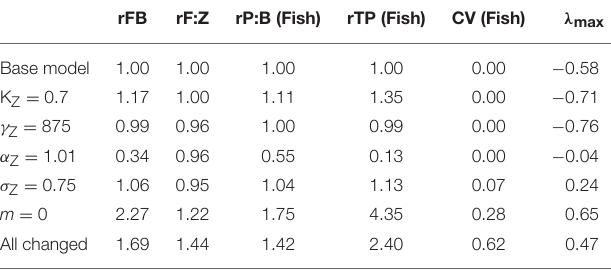
TABLE 3 | Fish community biomass (FB), fish to zooplankton biomass ratio (F:Z), fish community production to biomass ratio (P:B), and throughput (TP) relative to the base model (r), the variation in fish community biomass (coefficient of variation; CV) and the maxmium real part of the Jacobian ( λ max ) when the zooplankton community feeding parameters are updated one at a time, and